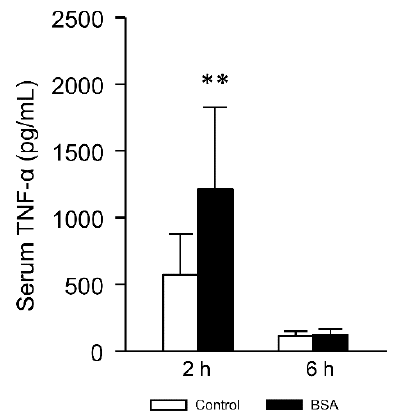
Figure 7. Effect of albumin interaction on serum TNF- α 2 h and 6 h after i.v. injection of lipoplex in hepatitis mice. Lipoplex was incubated with 5% glucose (control) or BSA. Each bar represents the mean + SD of at least 8 experiments. Statistical method, Student’s t -test. ** p < 0.01 vs. control.